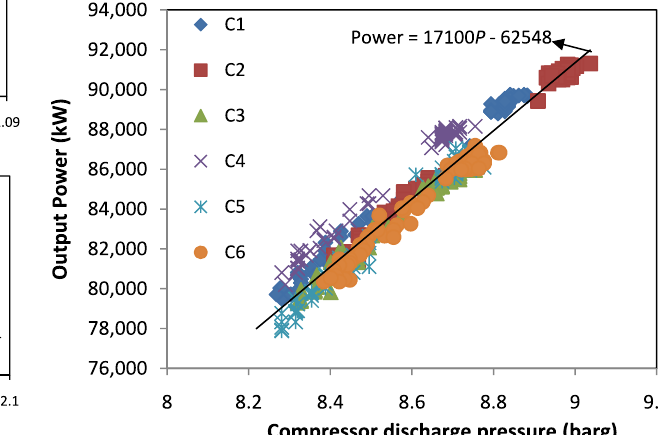
Fig. 4. Compression ratio against temperature ratio.